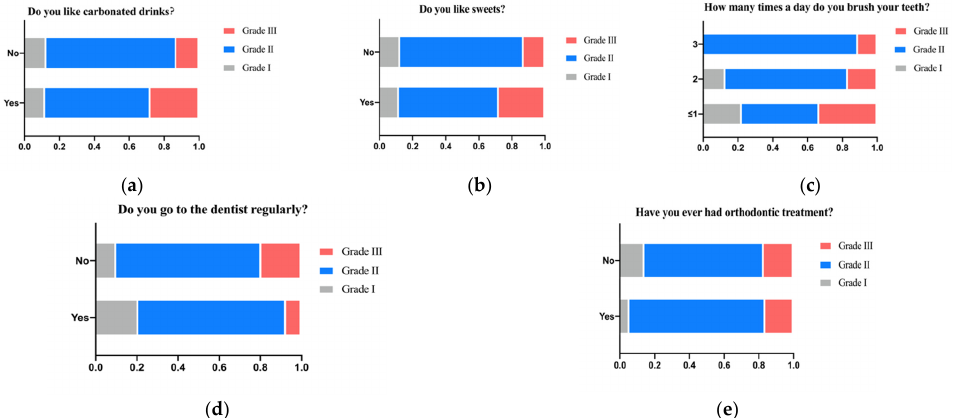
Figure 11. ( a ) Patients who like to drink carbonated drinks have a higher proportion of Grade III difficulty. ( b ) Patients who like sweets have a higher proportion of Grade III difficulty. ( c ) Patients who brush their teeth less than once a day have a higher proportion of Grade III difficulty. ( d ) Patients who go to the dentist regularly have a lower proportion of Grade III difficulty. ( e ) Patients who ever had orthodontic treatment have a lower proportion of Grade III